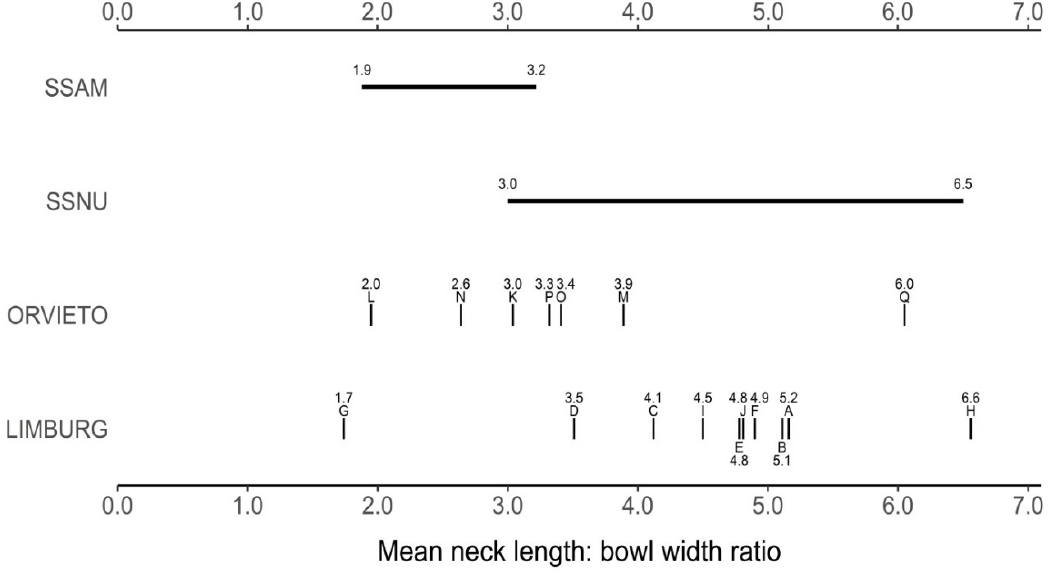
Figure 6. Mean perithecial neck length: bowl width ratios (NL: BW) of the Orvieto and Limburg hybrids and the parental O. novo-ulmi subspecies. Above, horizontal bars, SSAM, SSNU standards: published range of NL: BW means for the two subspecies [24]. Below, short vertical bars, NL: BW means of the seven Orvieto pairings, L to Q (middle row), and the ten Limburg pairings, A to J (bottom row). Isolate pairings as in Figure 3 legend.